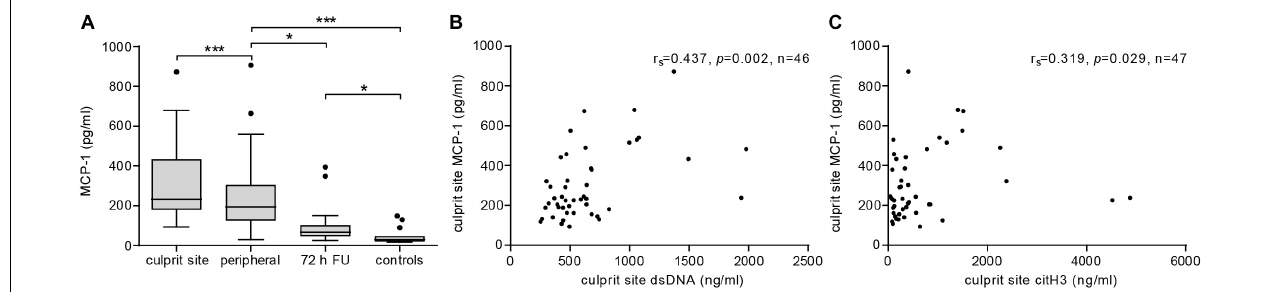
FIGURE 1 | MCP-1 and NETs are elevated at the culprit site in STEMI patients. (A) MCP-1 levels were measured in samples from culprit site ( n = 47), peripheral site ( n = 47), peripheral blood 72 h follow-up ( n = 19), and healthy controls ( n = 15) by ELISA. Statistical tests for respective pairwise comparisons and corrected and uncorrected p values are provided in Supplementary Table S1 . Data are presented as boxplots with whiskers defined according to Tukey. Culprit site MCP-1 concentrations were positively correlated with (B) local dsDNA (Spearman signed-rank test, r s = 0.437, n = 46) and (C) citH3 levels (Spearman signed-rank test,